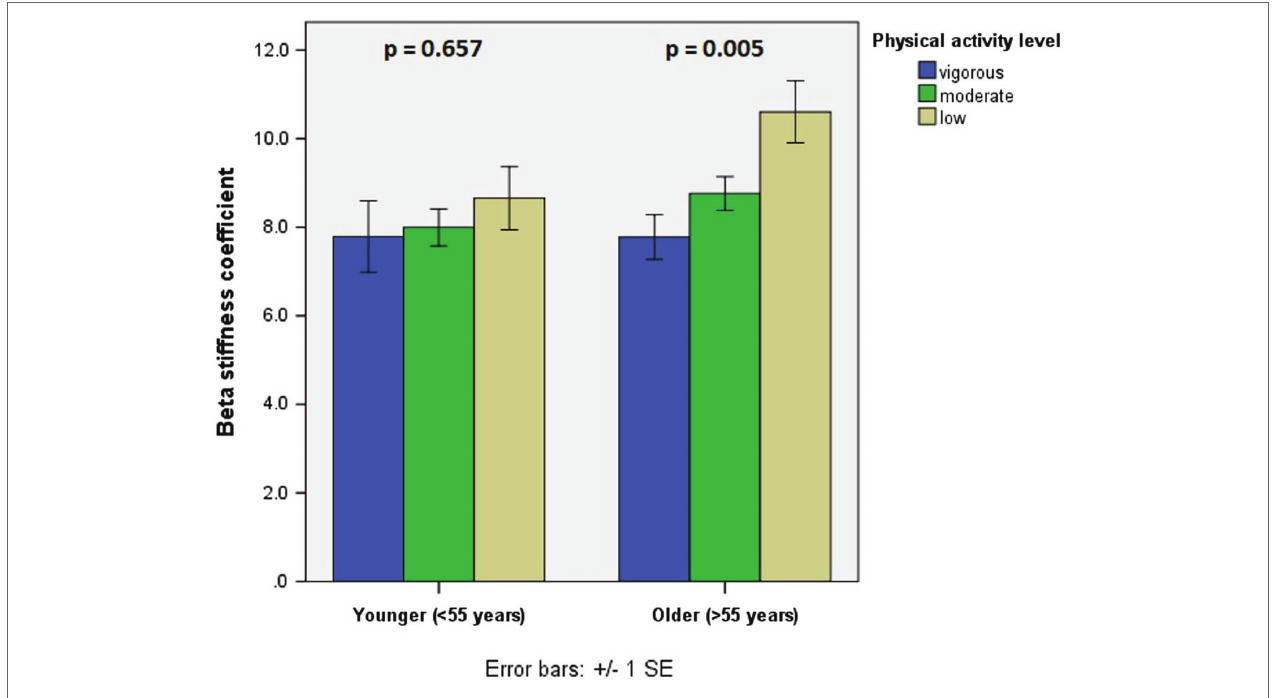
FIGURE 2 | Beta stiffness coefficient in different age groups in terms of physical activity